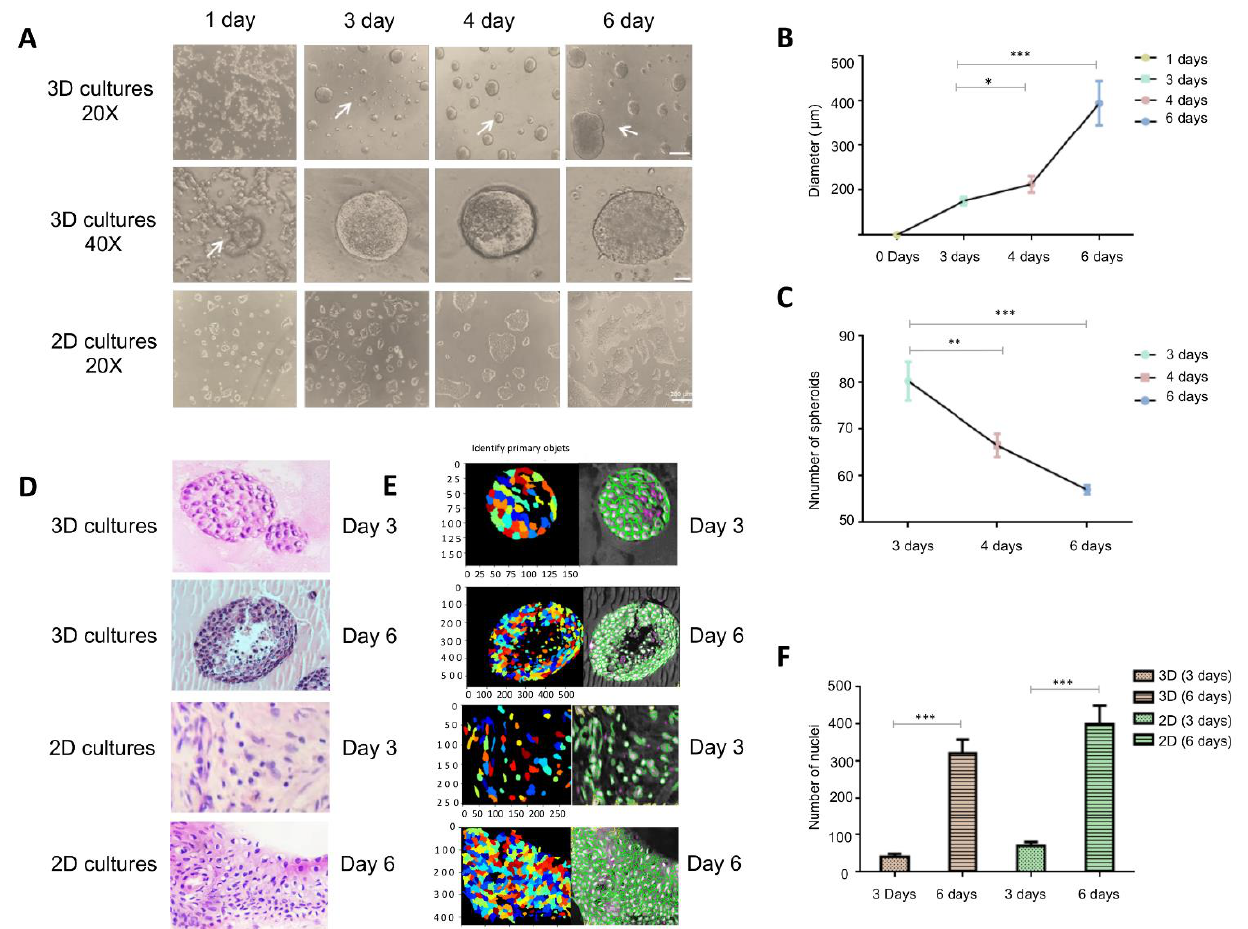
Figure 1. Generation and morphology of 3D organotypic cultures. ( A ) Growth kinetics of BT-474 cancer cells grown in 2D monolayers and 3D cell cultures observed in optical microscopy (20× and 40×) during 0 – 6 days incubation over Geltrex. ( B ) Quantification of the diameter of round-like structures in 3D cell cultures. ( C ) Quantification of the number of structures in 3D cultures at optimized seeding densities of 25,000 cells/well plate. ( D ) Hematoxylin and eosin staining of BT-474 cancer cells grown in 2D and 3D culture conditions. ( E ) Color image of 2D monolayers and 3D cell cultures using Identify Primary Objects module. Filter Objects module discards objects that have irregular shape or cell debris (magenta lines). ( F ) Quantification of number of nuclei present in 3D round-like structures. Values represent the mean ± SD from 3 independent experiments, using an unpaired Student’s t -test with unequal variances; * p < 0.05, ** p < 0.01, *** p < 0.001.